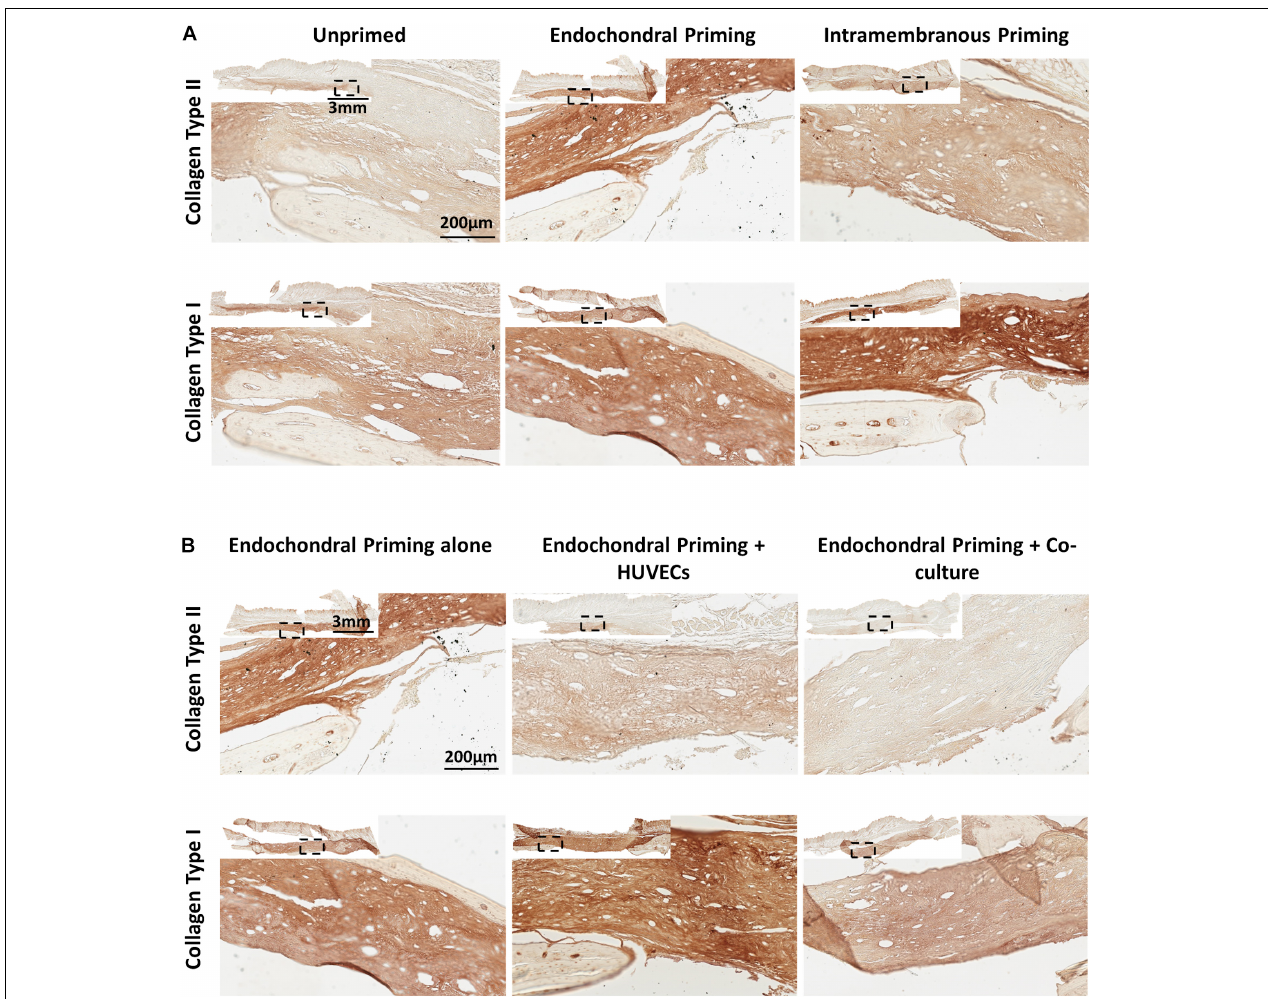
FIGURE 4 | (A) Immunohistochemistry (Collage Type I and Collagen Type II) stained sections of Unprimed, Endochondral and Intramembranous primed groups taken in the middle of the defect after 8 weeks in vivo. All Images taken at 20X. (B) Immunohistochemistry (Collage Type I and Collagen Type II) stained sections of Endochondral priming alone, Endochondral priming + HUVECs and Endochondral priming + Co-culture groups taken in the middle of the defect after 8 weeks in vivo. All Images taken at